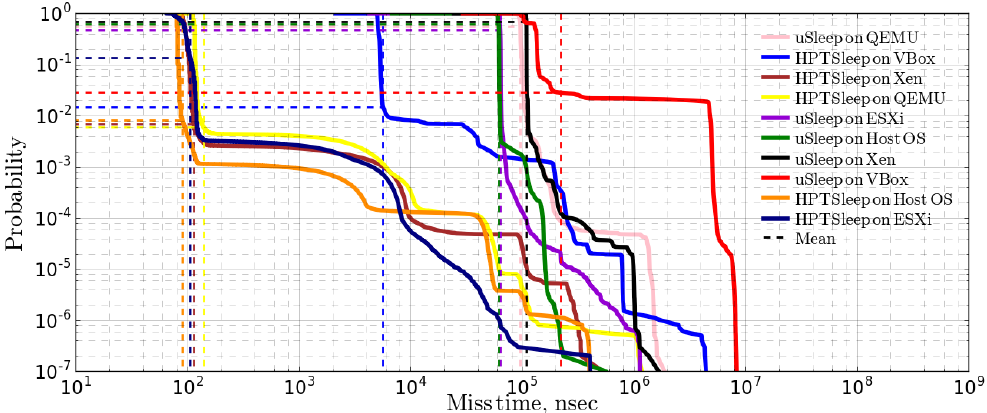
Figure 11. CCDF representation of measurements of miss time for the idle testbed.